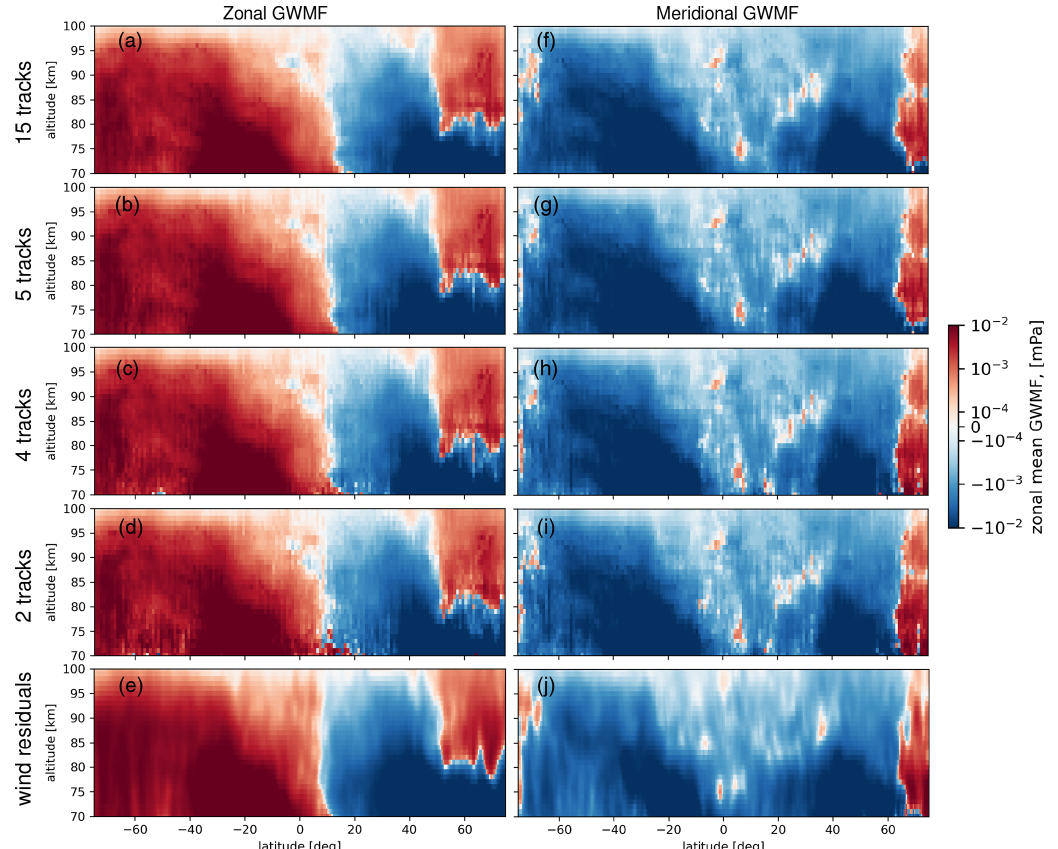
Figure 13. Zonal (a–d) and meridional (f–i) zonal mean GW momentum flux in 1 ◦ latitude bins from sampled and retrieved orbit-track HIAMCM temperature data for 1 January 2016 at 06:00UT using the S3D fitting method and polarization relations. Four cases as in Fig. 10 are listed. GWMF values (e, j) directly inferred from wind fluctuations are also given, which are running-averaged over 5 ◦ latitude bins and vertically running-averaged over 5km